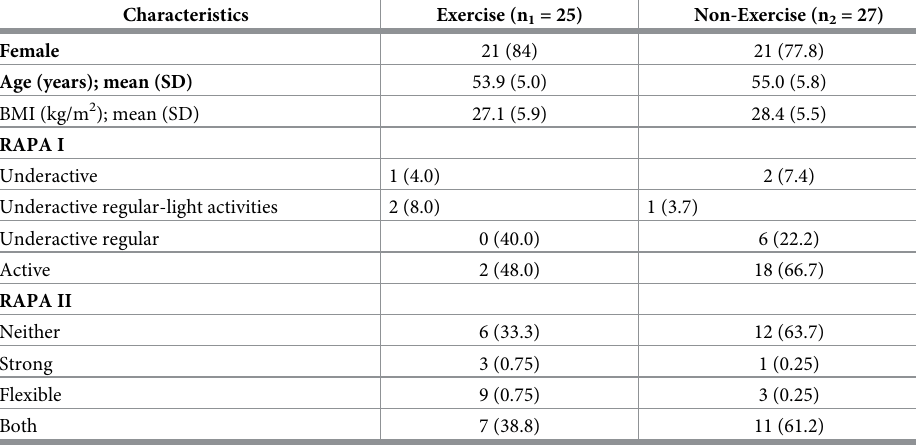
Table 2. Frequency (%) of general characteristics by study group (N =